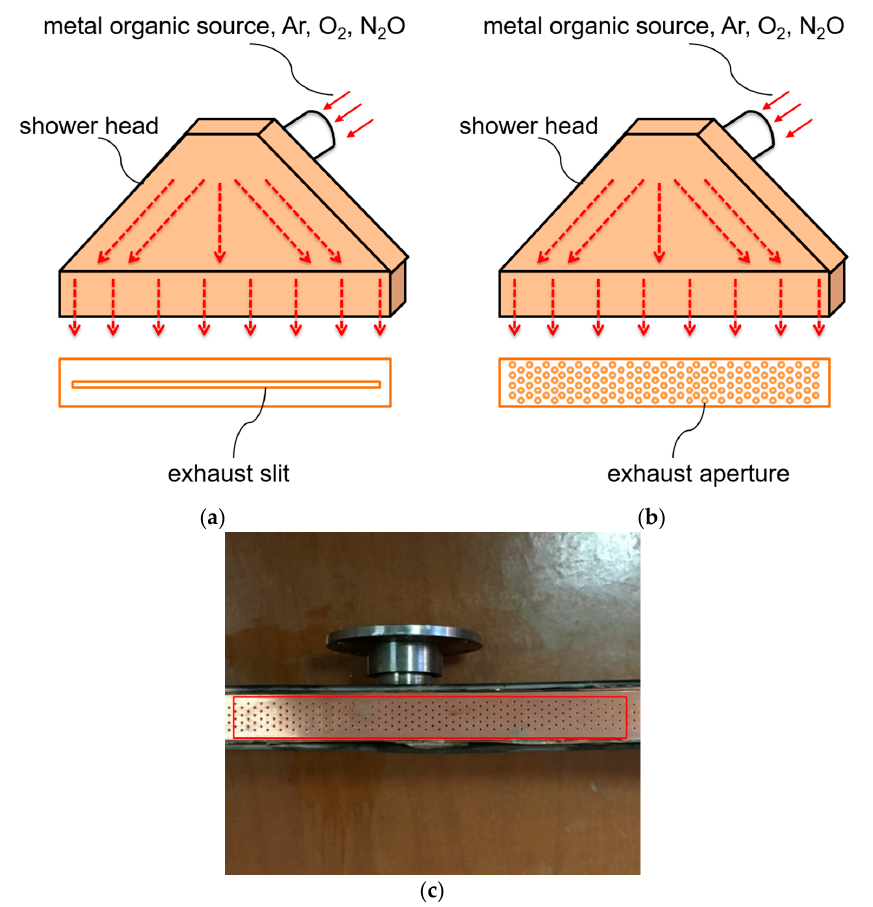
Figure 2. ( a ) The schematic diagram of the slit shower; ( b ) The schematic diagram of the multi- aperture shower; ( c ) A picture of the multi-aperture